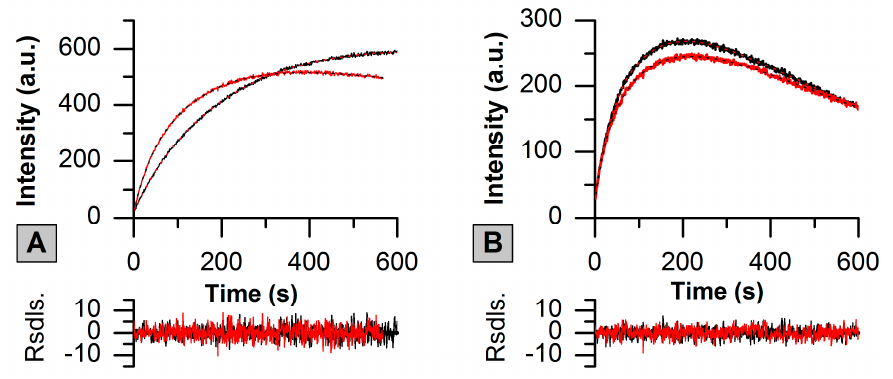
Figure 3. Kinetics of green-to red photoconversion of SAASoti (lines) with three-exponential fits (dots) and the fits’ residuals at the bottom. Time dependencies of fluorescence intensity at 590 nm under 400 nm illumination (black, R1 formation) and with prior 470 nm light exposure (10 min) of the sample (red, R2 formation). ( A ) Freshly prepared sample; ( B ) ‘Old’ SAASoti sample. TBS buffer, pH 7.4.